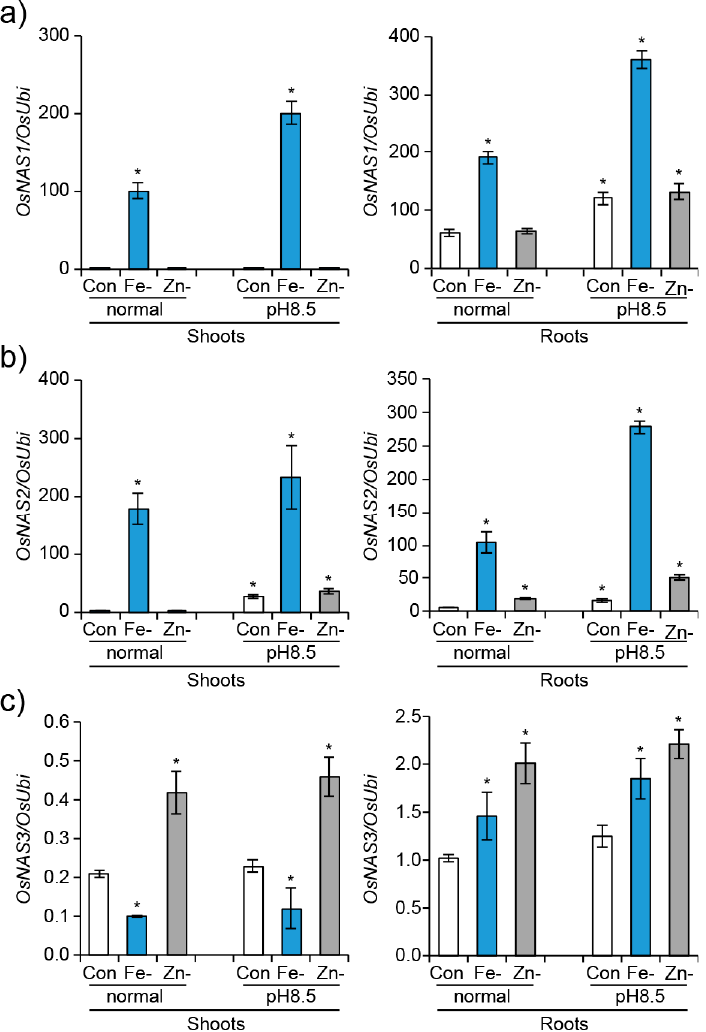
Figure 3. Elevated expression of OsNAS genes by high pH. Expression of OsNAS1 ( a ), OsNAS2 ( b ), and OsNAS3 ( c ) grown under normal (pH 5.5) or high pH (pH 8.5) Yoshida solution with Fe and Zn (Con), or without Fe (Fe-) or Zn (Zn-). Plants were grown in normal Yoshida solution for 7 days and thereafter were transferred to each growth condition. The seedlings were grown for an additional three days, and shoots and roots from the seedlings were sampled for RNA isolation. Significant differences between the control (pH 5.5) and each growth condition are indicated with an asterisk (* p < 0.05 by Student’s t -test).